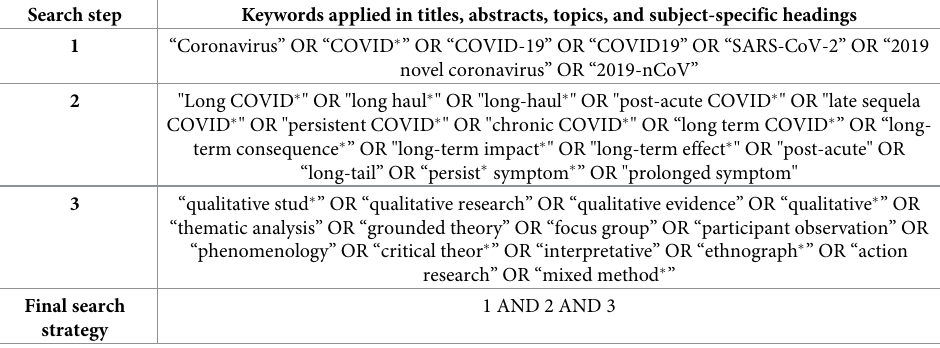
Table 1. Search strategy for systematic literature